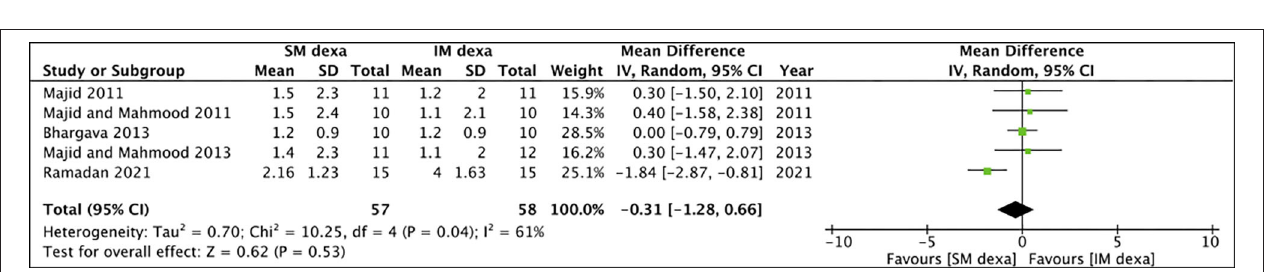
FIGURE 8 | Meta-analysis of early pain between SM and IM dexamethasone (dexa) for third molar surgeries.